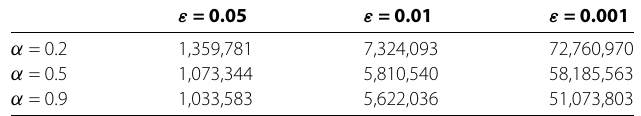
Table 1 The posteriori regularization parameter m under different α and ε for Example 1 ε = 0.05 ε = 0.01 ε = 0.001 α = 0.2